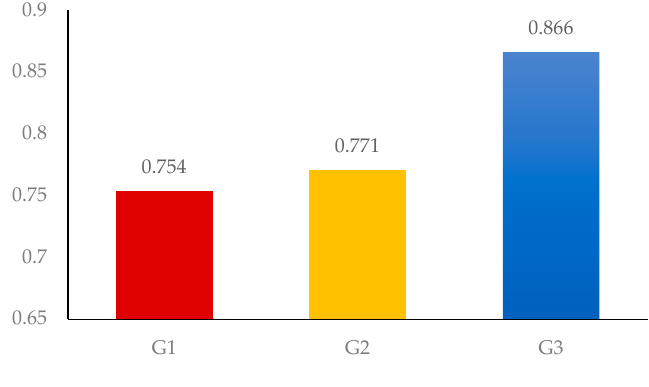
Figure 4. Results for each group.